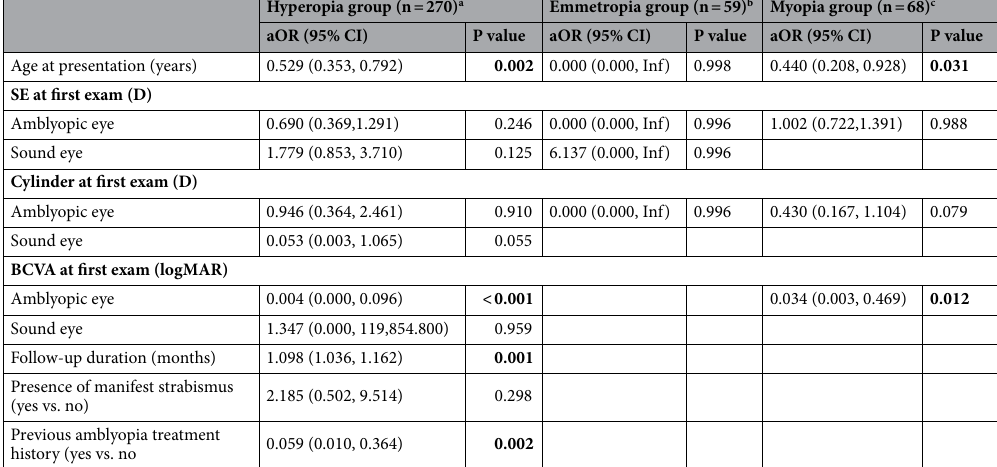
There are diverse reports about treatment outcome of anisometropic amblyopia. However, as the hyperopic difference in refractive error are more amblyogenic than myopic differences 14 , many anisometropic amblyopia studies were comprised of mostly hyperopic patients 6,15,16 . Small number of papers have analyzed treatment outcome according to refractive error type of amblyopic eye. Keech et.al. reported that the refractive error type of anisometropia was significant factor affecting anisometropic amblyopia treatment outcome as patients with myopic and compound myopic/mixed astigmatism had poorer visual outcomes than hyperopia 7 . On the contrary, Meenakshi et al. found that greatest amount of improvement in visual acuity was seen in myopic anisometropic patients and the least in hyperopes 5 . Husseint et al. reported that the refractive error type of amblyopia was not a significant factor for amblyopia treatment outcome 15 . Our study classified anisometropic amblyopia as hyperopia, emmetropia, and myopia groups according to SE of amblyopic eye at first exam and analyzed the factors for treatment success. Treatment success rates during the follow-up were the highest in emmetropia group, followed by hypero- pia group and then myopia group. This result is in accordance to our previous study 13 , even though this study